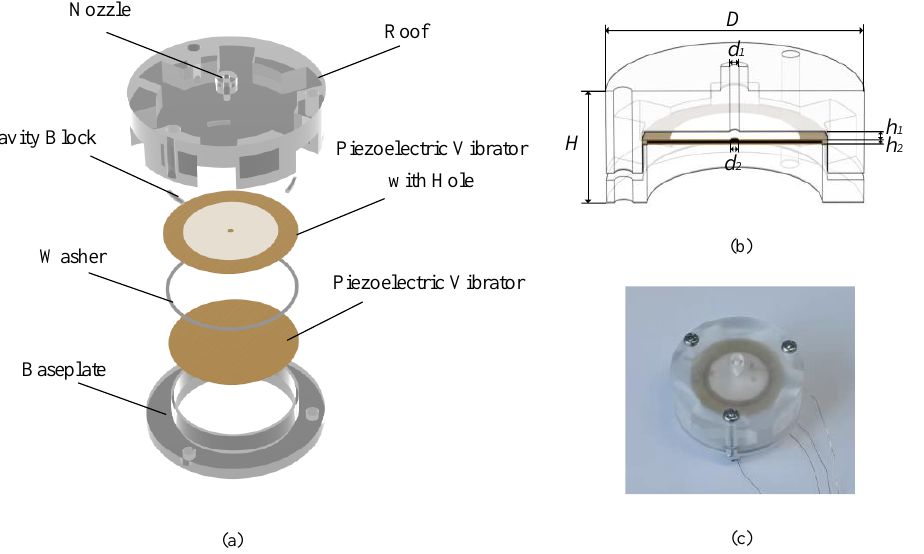
Figure 2. Model and prototype of the piezoelectric micropump: ( a ) explosive view; ( b ) cross-sectional view; ( c ) prototype.